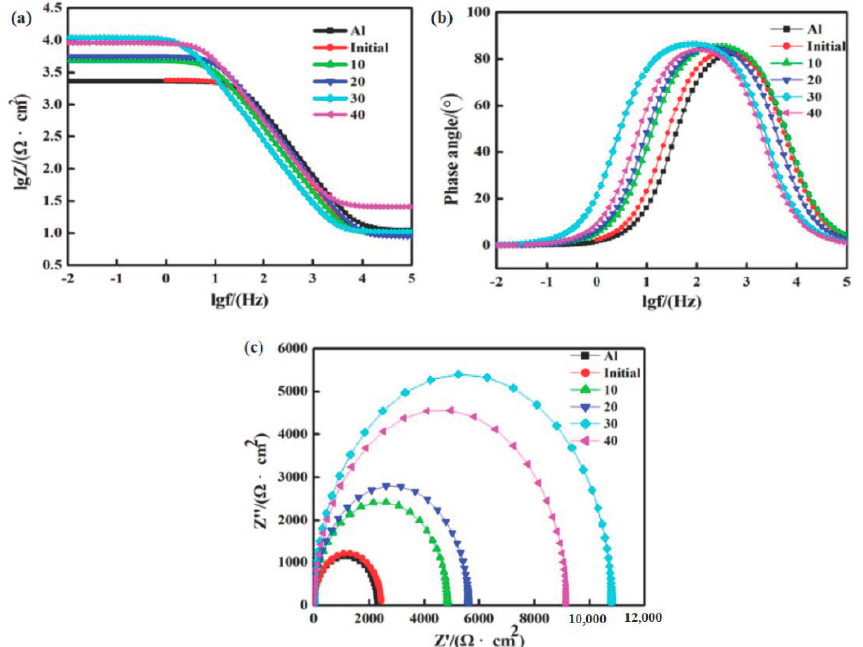
Figure 9. EIS of samples in 3.5 wt% NaCl before and after HCPEB alloying of Zr: ( a ) impedance magnitude and frequency, ( b ) phase angle and frequency, and ( c ) Nyquist plot.